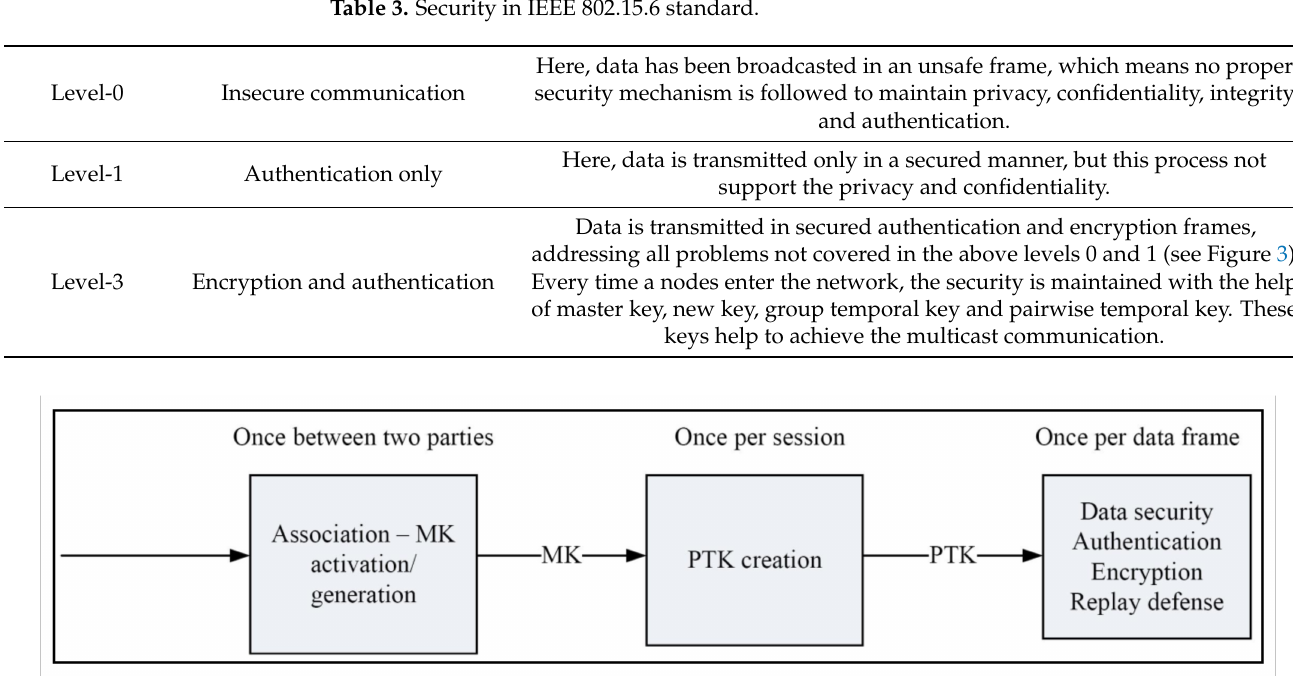
Figure 3. IEEE 802.15.6 standard security